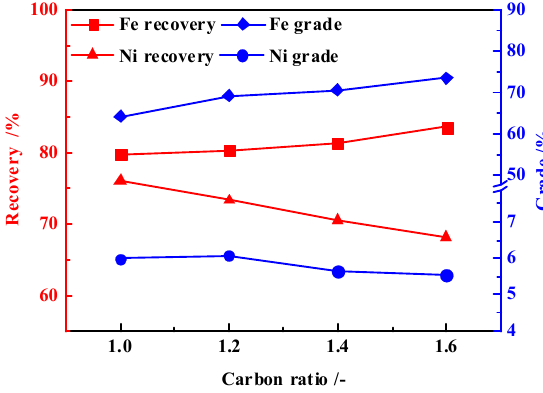
Figure 9. Effects of carbon ratio on grades and recoveries of Ni and Fe.